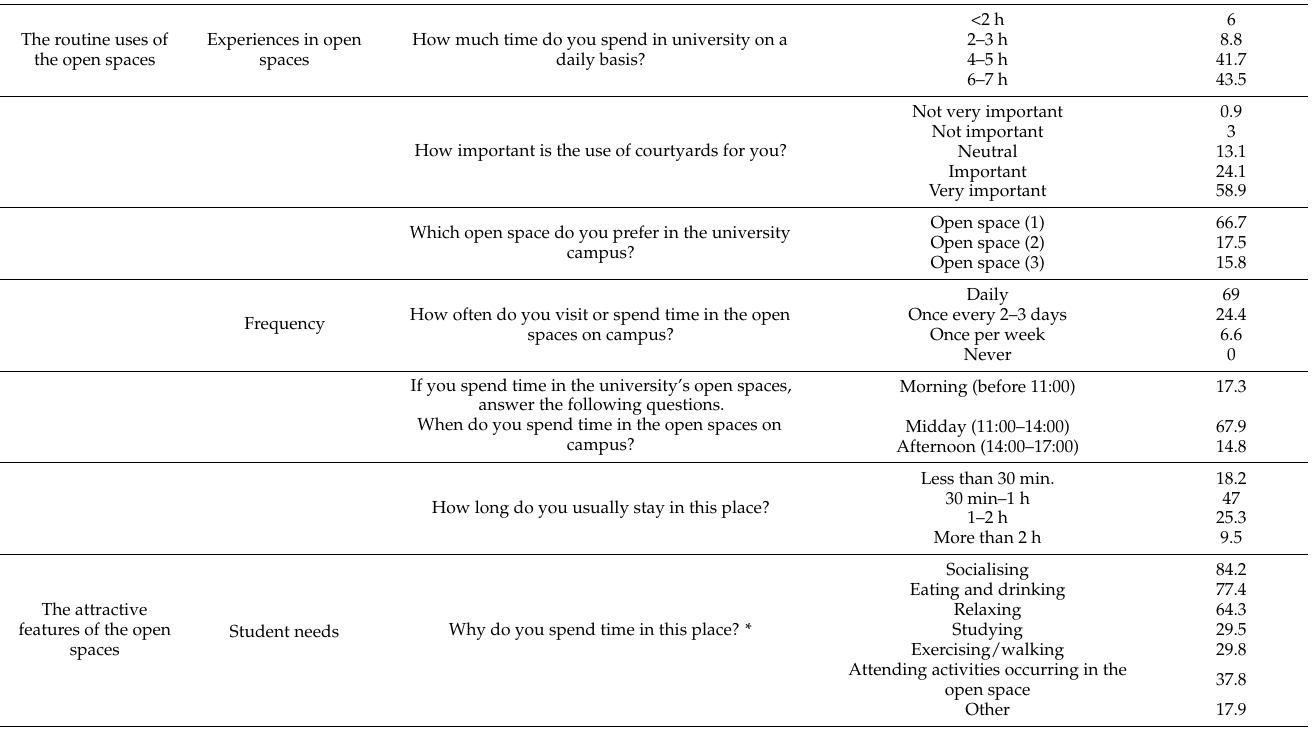
Table A3. Descriptive statistics on the three dimensions of open space experience in student responses of the questionnaire.